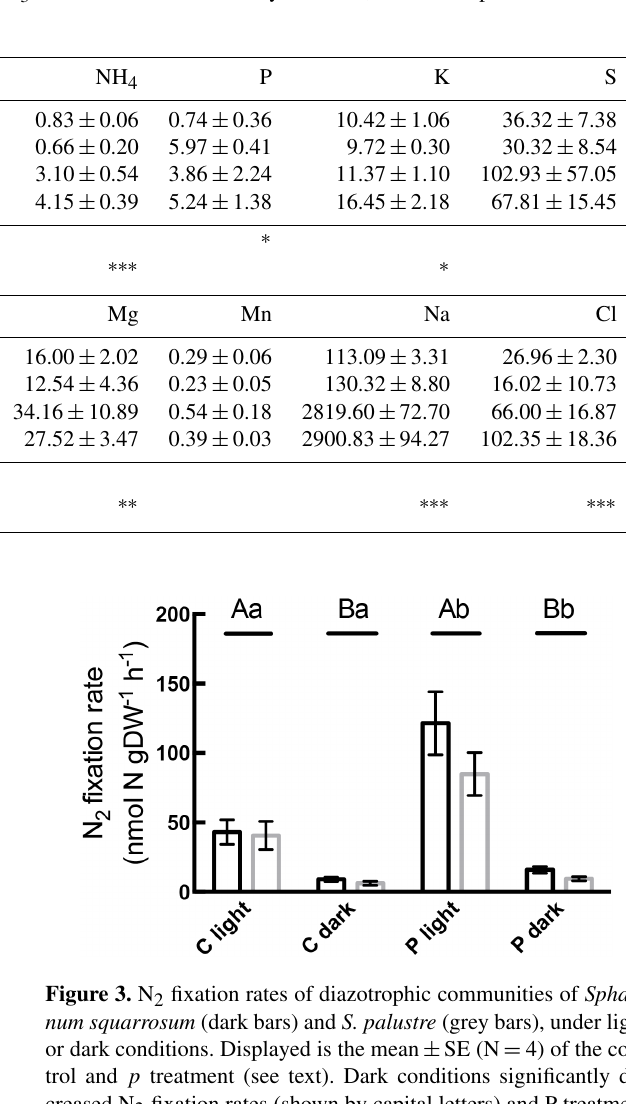
(HCO 3 ) , or both (P + HCO 3 ) . 3